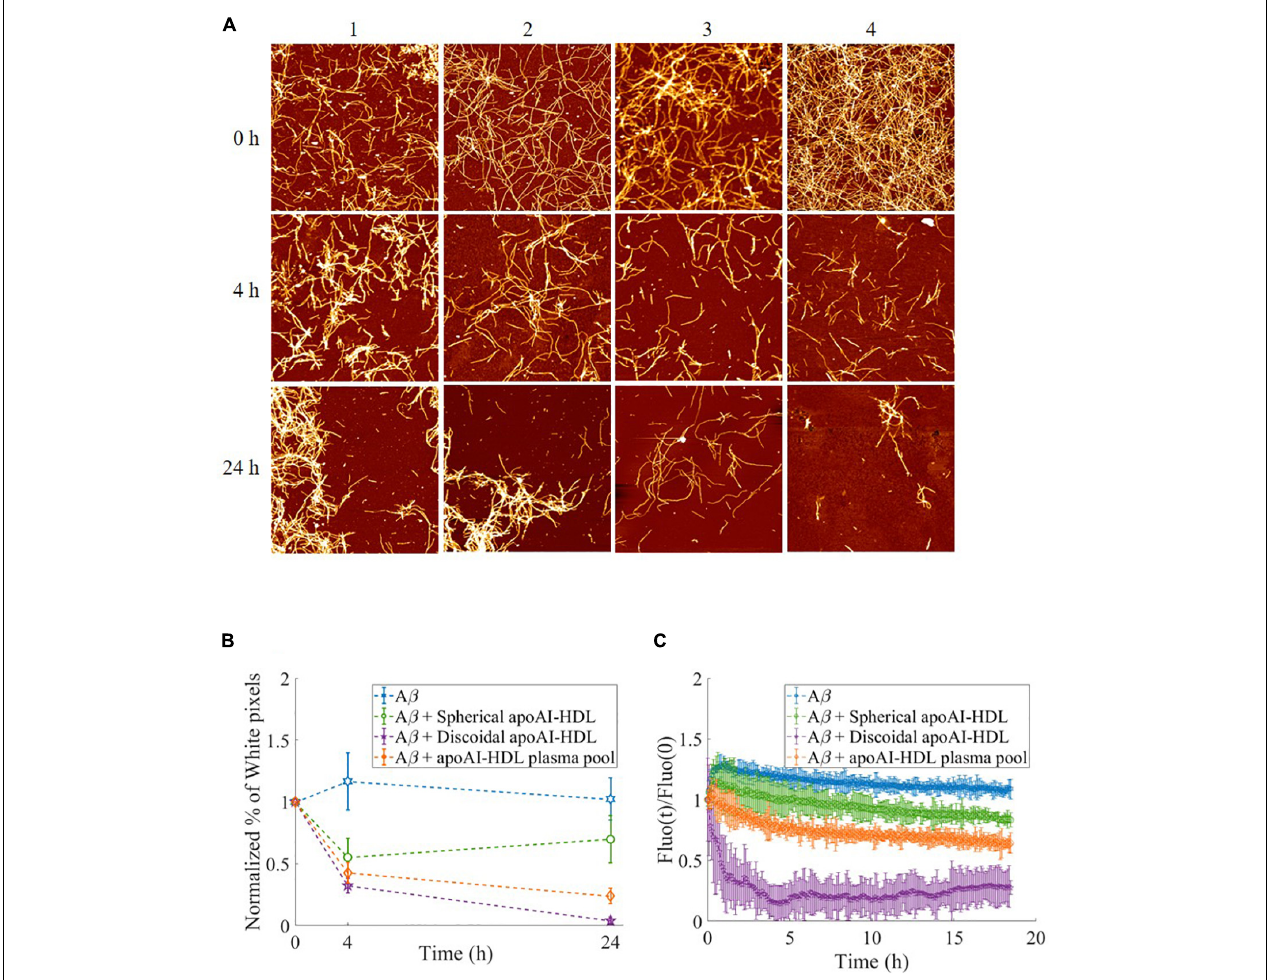
FIGURE 7 | Disaggregation of preformed A β fibrils in the presence of HDL. (A) Representative AFM images of A β fibrils over time, incubated at 37 ◦ C either alone (column 1) or with different HDL subclasses: spherical HDL (column 2), total HDL plasma pool (column 3), discoidal HDL (column 4). Images are 4 µ m 2 × 4 µ m 2 , 1024 × 1024-pixel, Z-scale 10 nm. (B) The normalized percentage of pixels with a height above a threshold of 1.5 nm (white pixel percentage) is reported for A β in the presence of the different HDL subclasses at different incubation times. Values are the average of pixels higher than the threshold over several images acquired on the same sample. Error bars represent SD Each sample is normalized to its respective starting point (value at t = 0 h). (C) Thioflavine T fluorescence as a function of time in samples containing 2 µ M A β fibrils alone (blue dotted) or incubated with spherical HDL (green dotted), total HDL pool (orange dotted), or discoidal HDL (purple dotted). The intensities were normalized to the respective zero-time